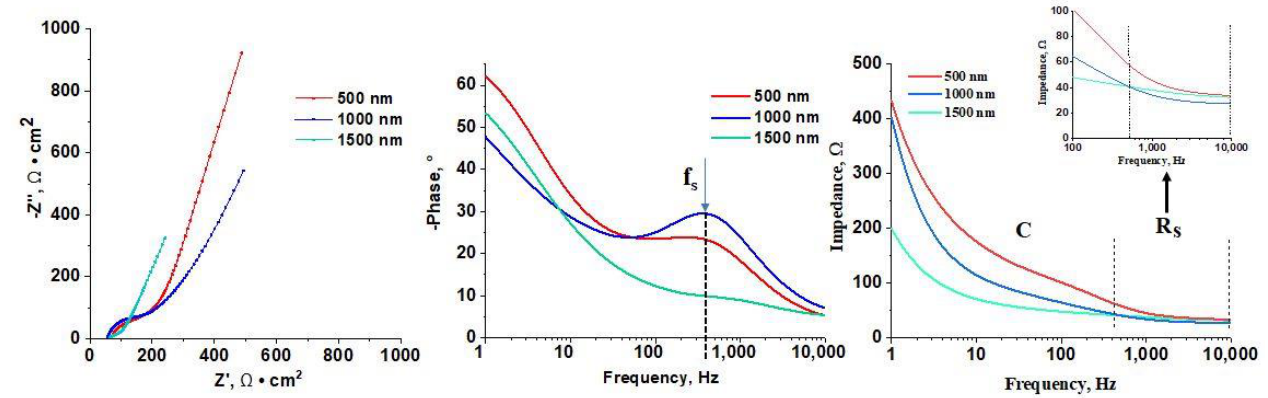
Figure 1. Nyquist plots of PNaSS@ PEDOT microsphere films with different thickness ( a ), corre- sponding Bode plots ( b ), and impedance vs. frequency ( c ); the inset is the frequencies range from 500 to 10 kHz.